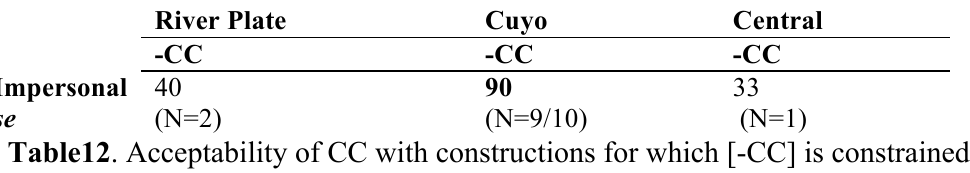
Table12 . Acceptability of CC with constructions for which [-CC] is constrained prescriptively (impersonal se